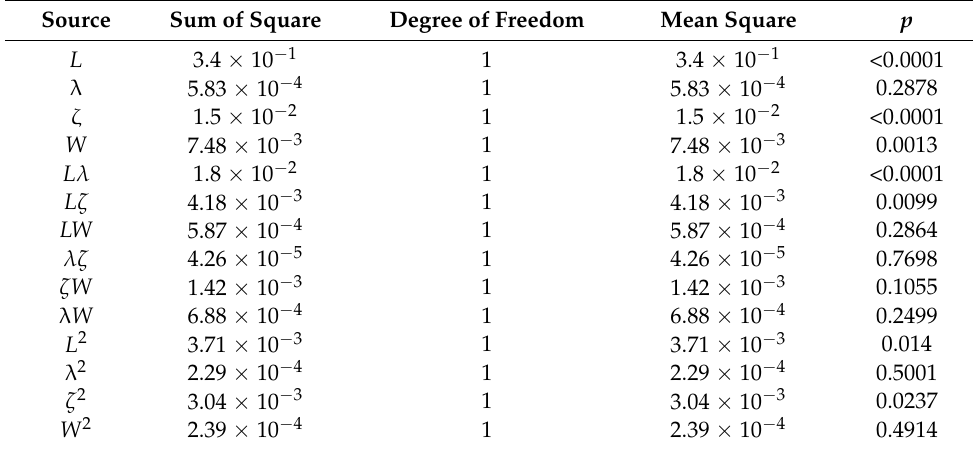
Table 4. Preliminary significance analysis results of model Φ D